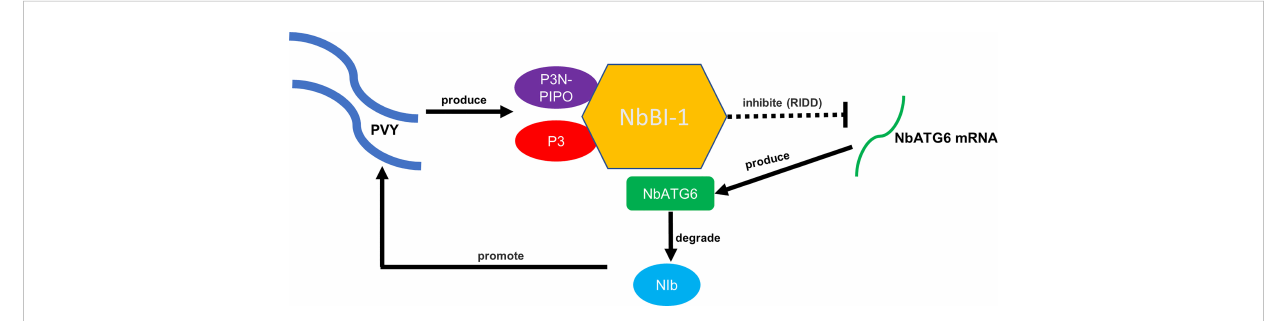
FIGURE 6 A working model of NbBI-1-mediated PVY infection breaking through the autophagic defense of N. benthamiana